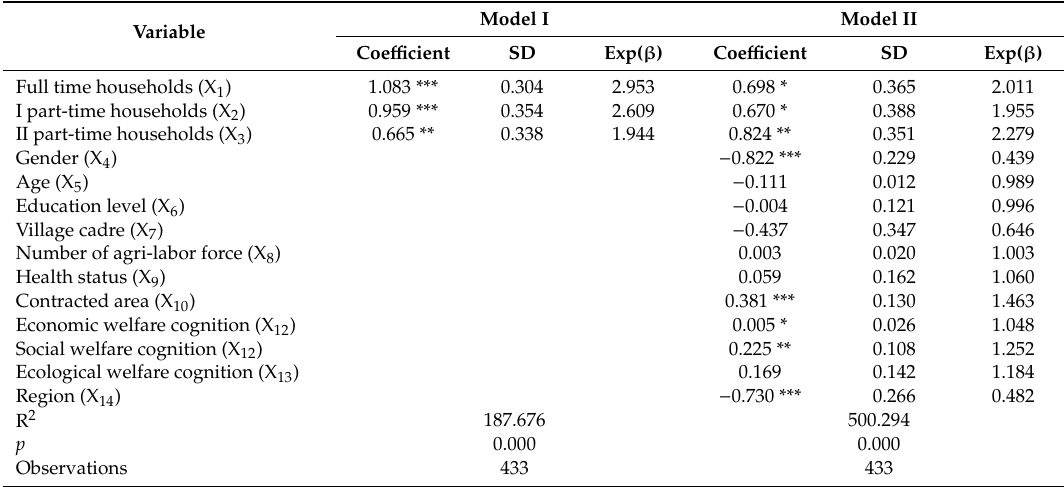
Table 5. Results of the impact of part-time farming on the CA technology